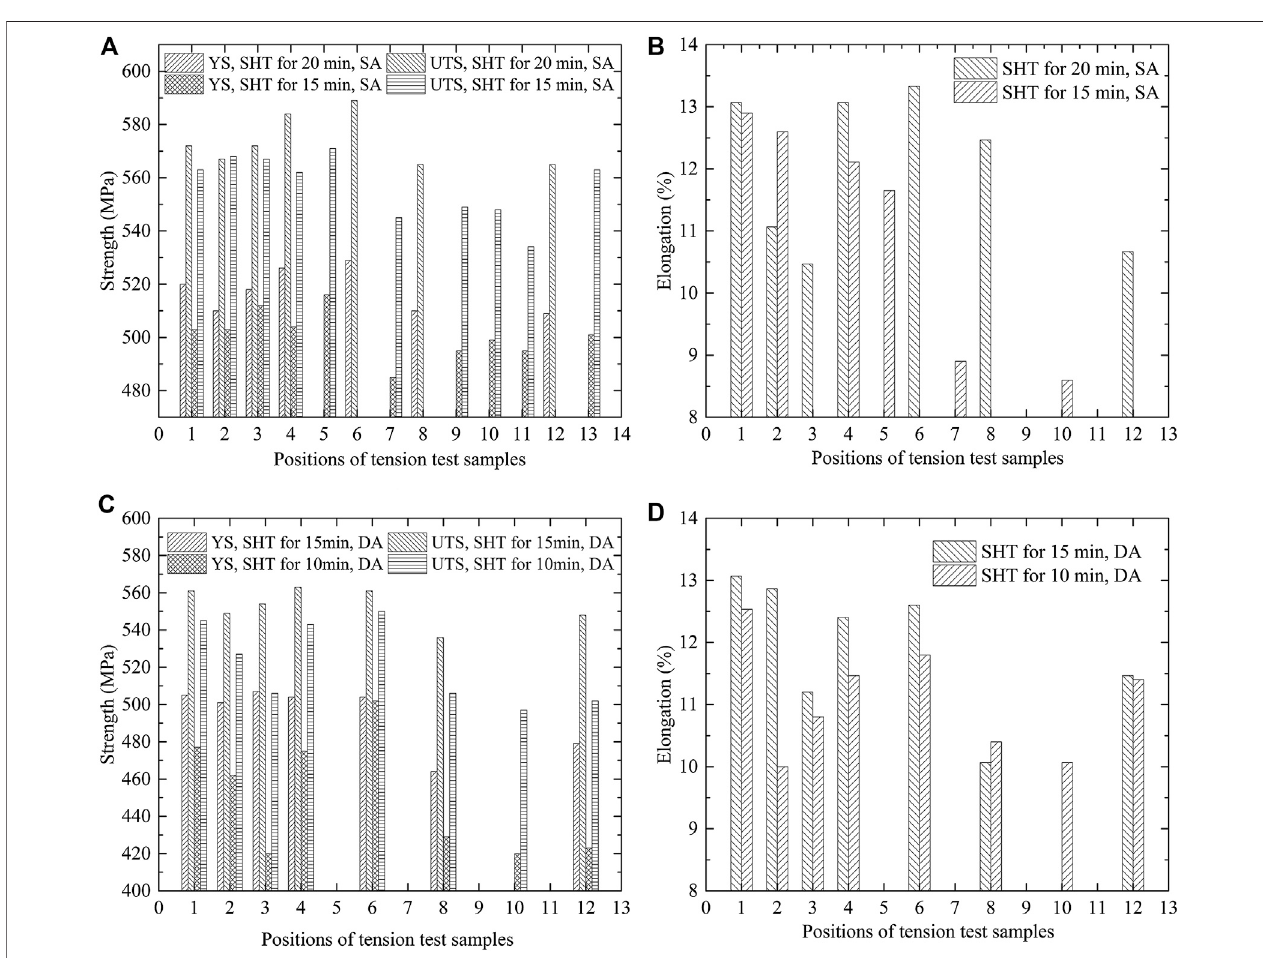
FIGURE 7 | Strength and elongation of samples under different process